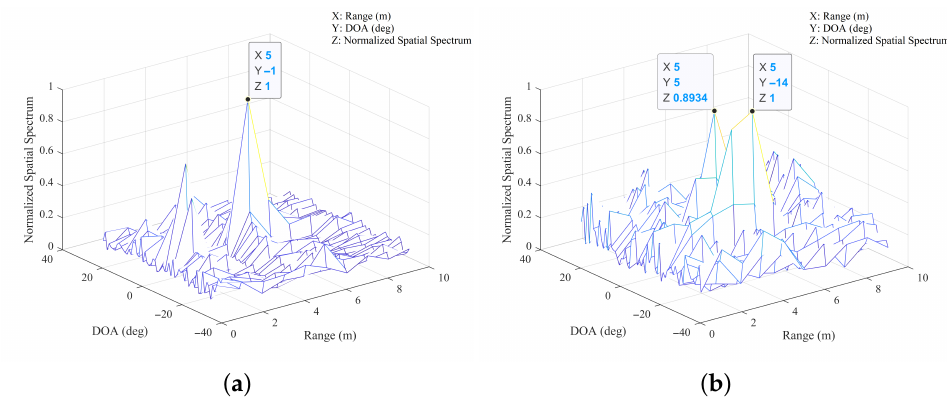
Figure 15. Low-resolution imaging: ( a ) Single target. ( b ) Two targets. Figure 16a,b shows the residual images obtained via VDSR from the low-resolution images of the one and two-target experimental data, with resolutions of 0.1 ◦ and 0.1 m, respectively. It can be obviously observed that the missing high-frequency information of the low-resolution image was reconstructed to correct the peaks and